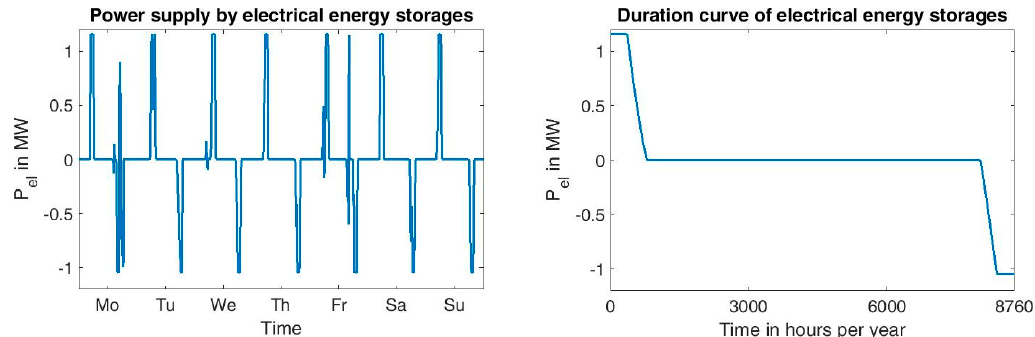
Figure 13. Exemplary P2G utilization profile for a chosen week (electrical input power) and the corresponding annual duration curve.